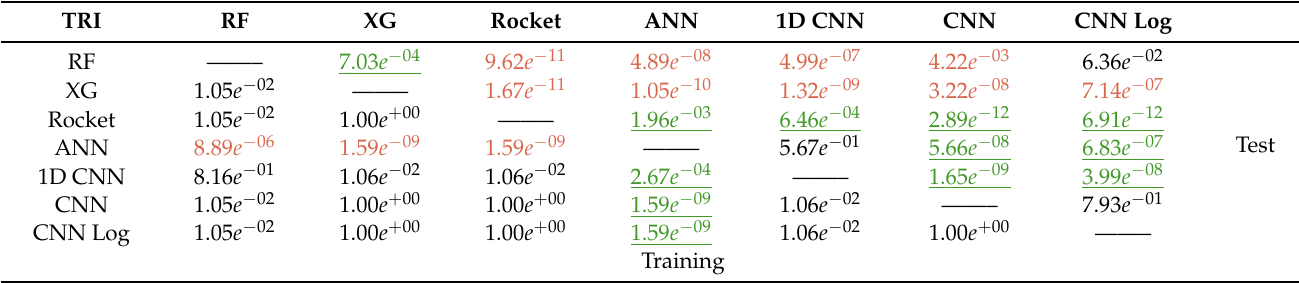
Table A8. Kruskal–Wallis p -values comparing all methods of the TRI concentration prediction task. Above the diagonal, we have the results for the test set, and below for the training set. Significant results ( p < 0.01) are represented in green or red when the method on the left is significantly better or worse, respectively.